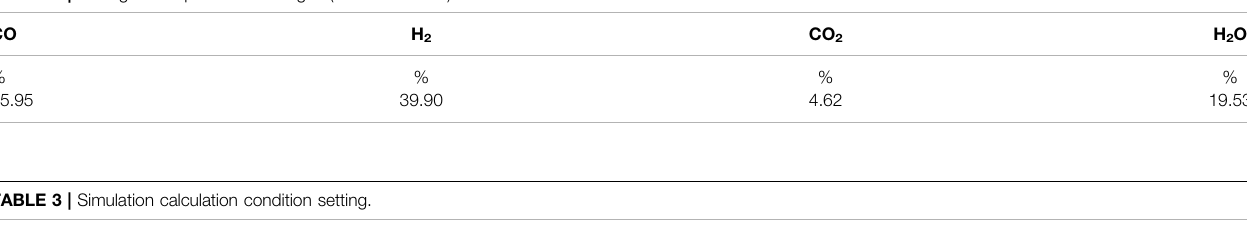
TABLE 2 | Main gas components of tail gas (volume fraction).